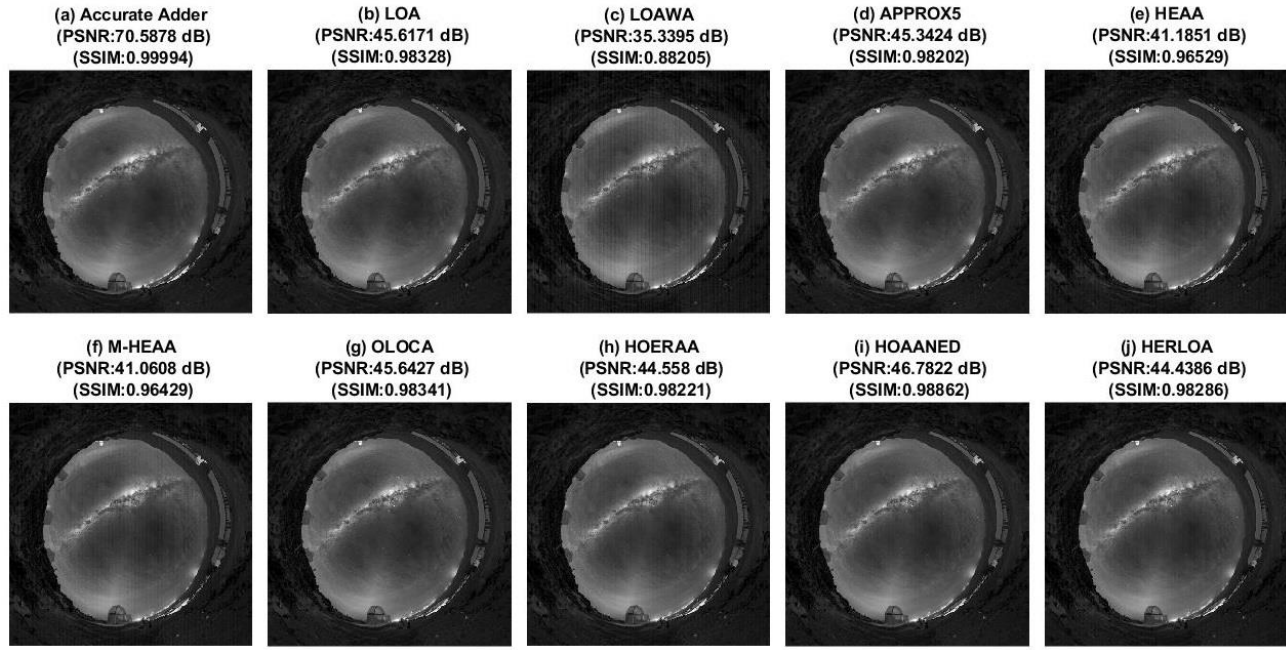
Figure 3. La Silla image compressed using accurate adder and different approximate adders, with the approximate adders having a 10-bit inexact part.